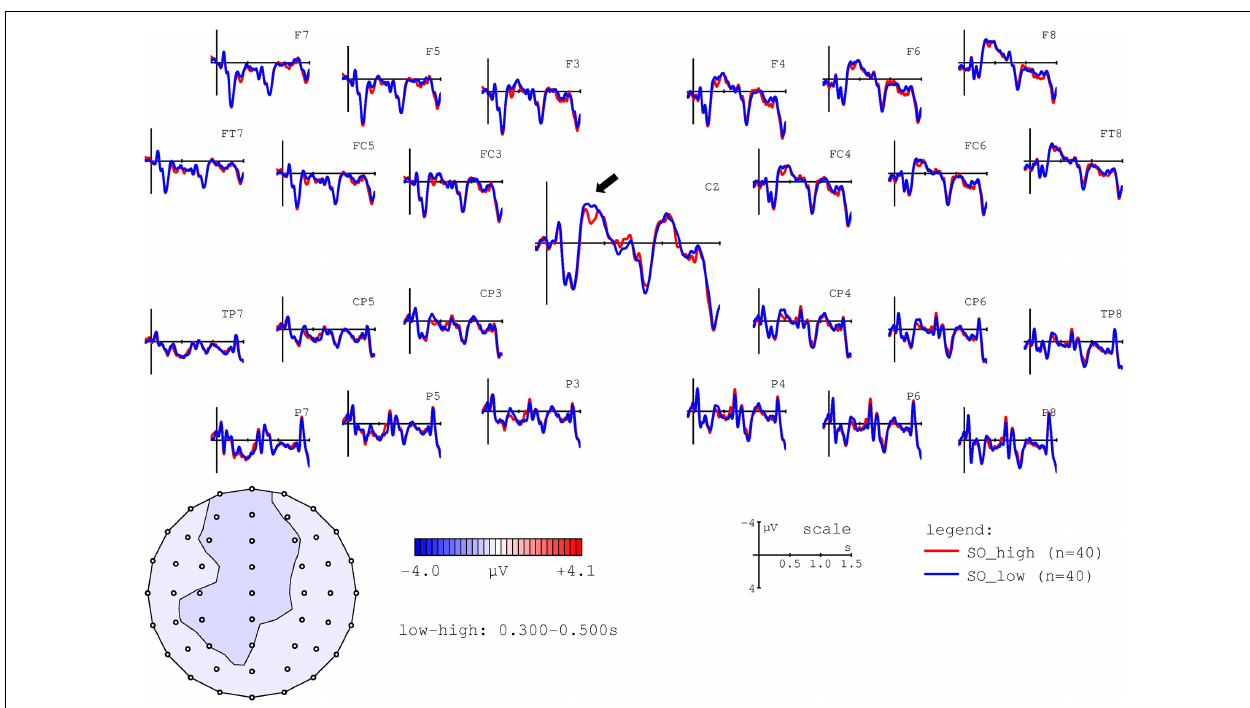
FIGURE 5 | Grand average ERPs time-locked to the second NP (onset at the vertical bar) for high (red line) and lowACT (blue line) nouns in subject-initial sentences. Negativity is plotted upward.The voltage map shows the topography of the effect (amplitudes for low – high ACT nouns in the 300–500 ms time window).